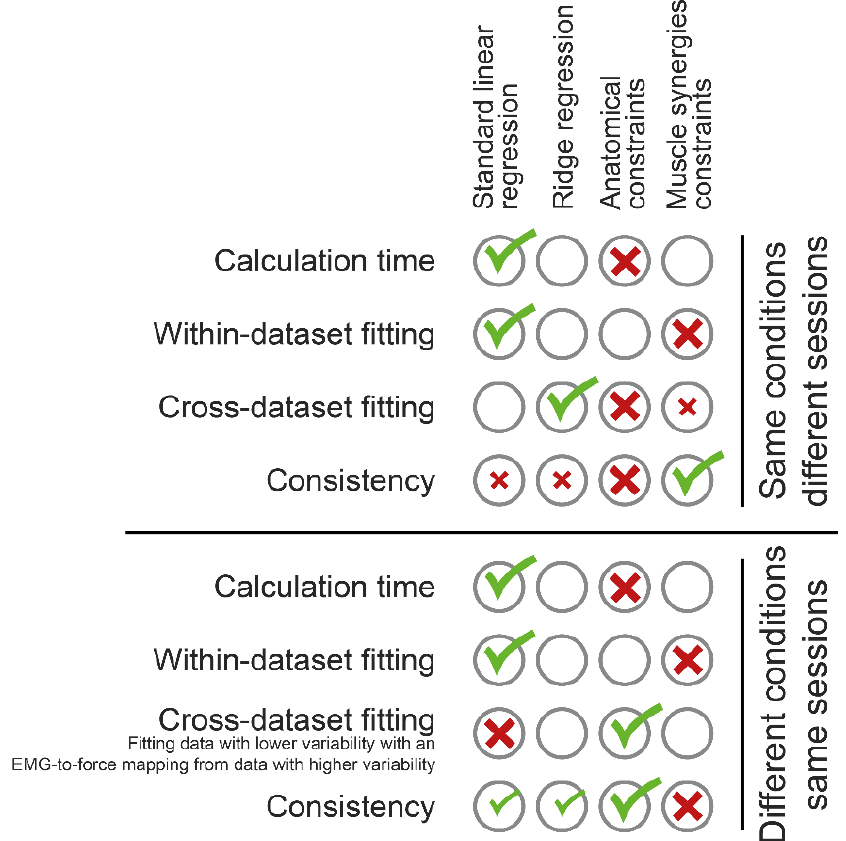
Figure 9. Summary of results. For each comparison metric, the best approach was indicated with a green tick, while the worst approach was indicated with a red cross. Smaller ticks indicate approaches not showing statistical difference with respect to the best approach. Similarly, smaller crosses indicate approaches not showing statistical difference with respect to the worst approach. Among the results got when different conditions were required, the only ones got after fitting a data subset with a mapping extracted from another data subset showing a higher variability, are reported in the